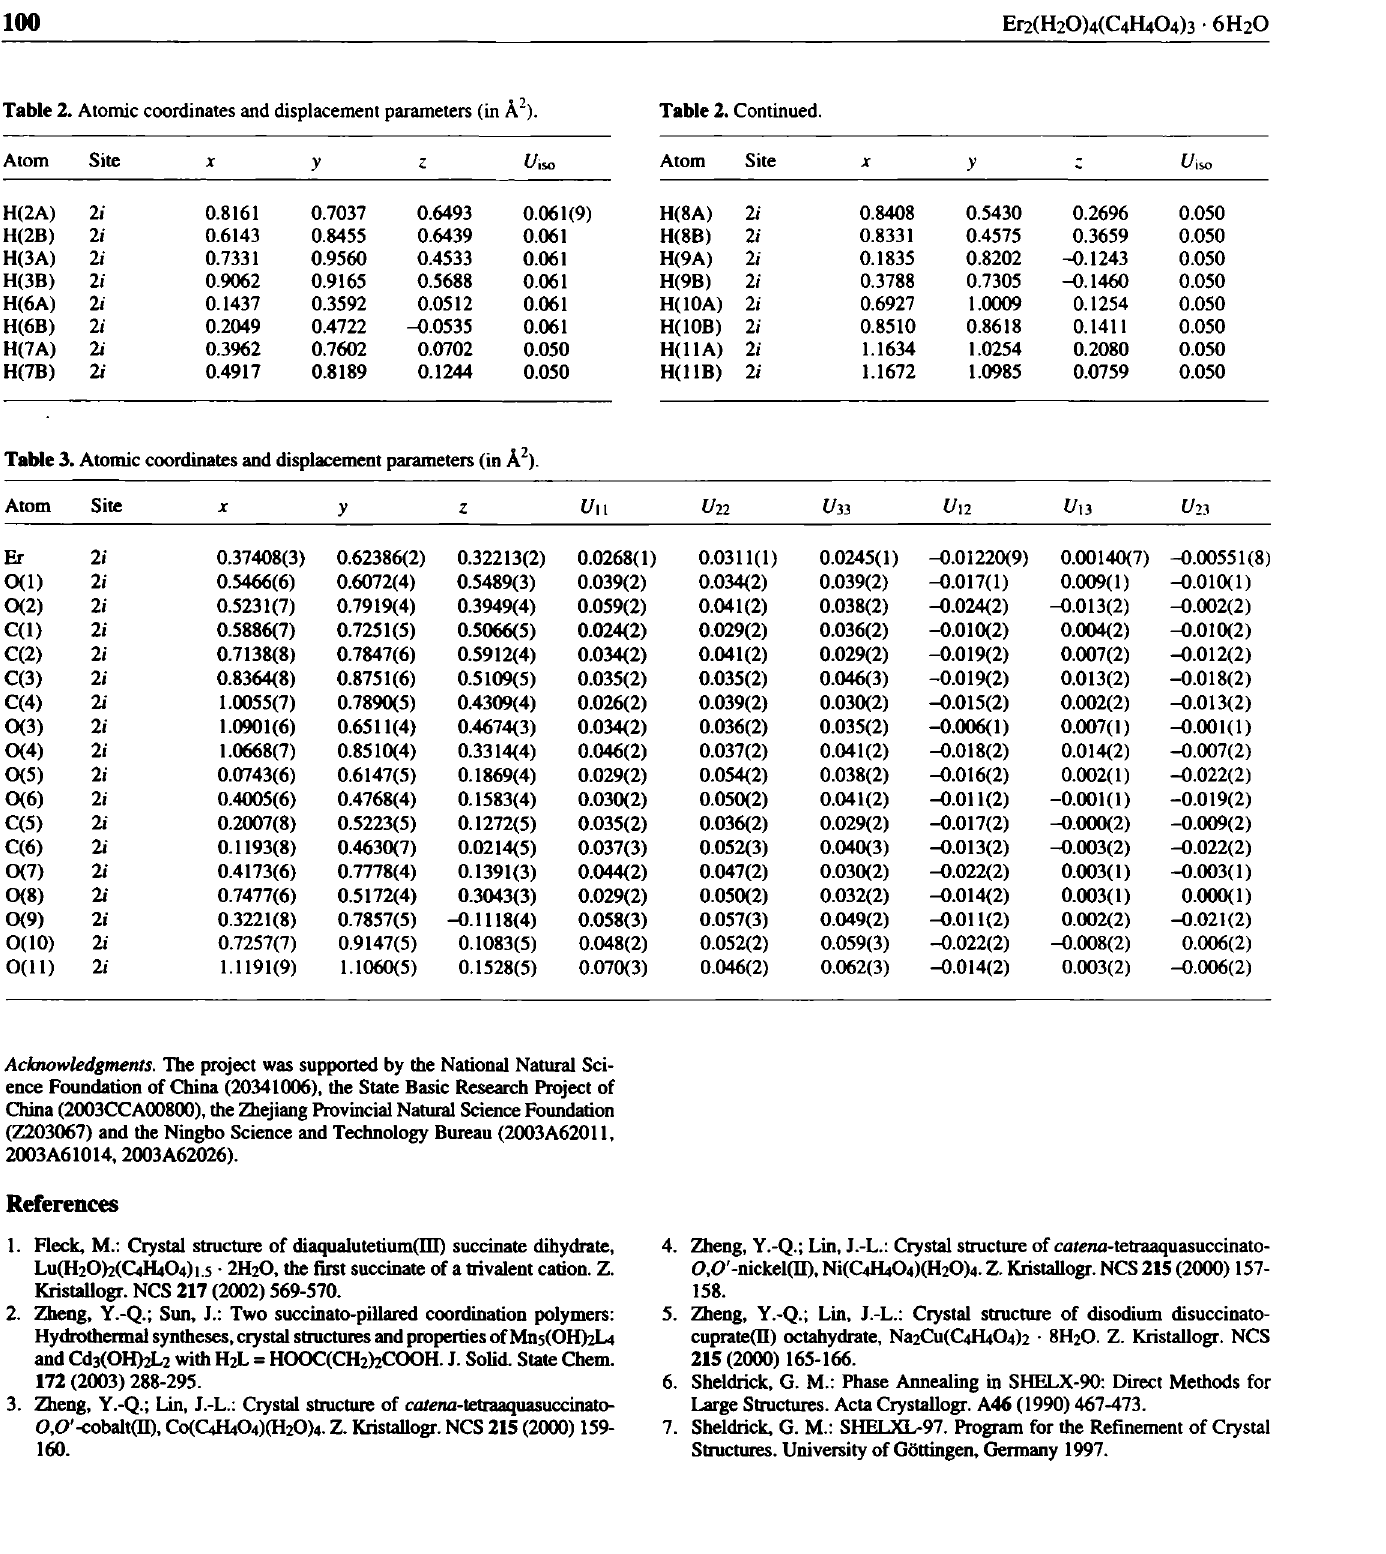
Table 3. Atomic coordinates and displacement parameters (in Â 2 ).